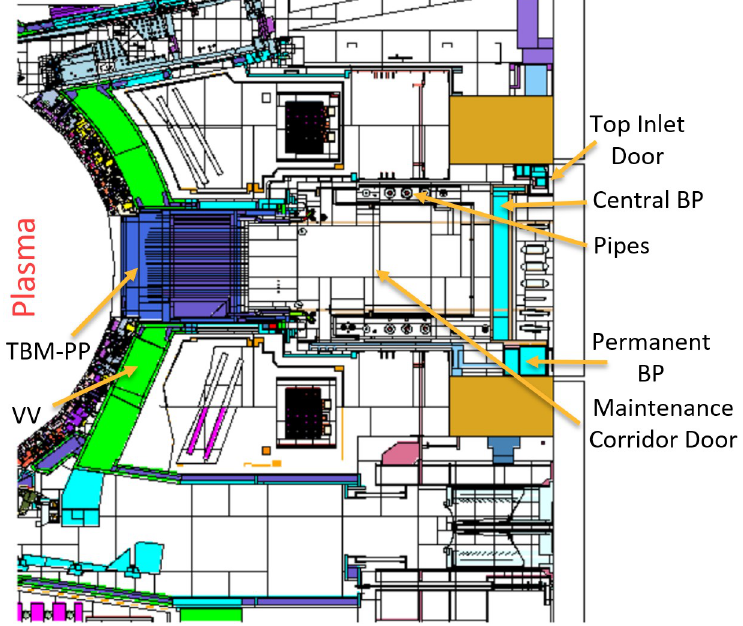
Figure 5. Integrated PF, BP, and TBM-PP into